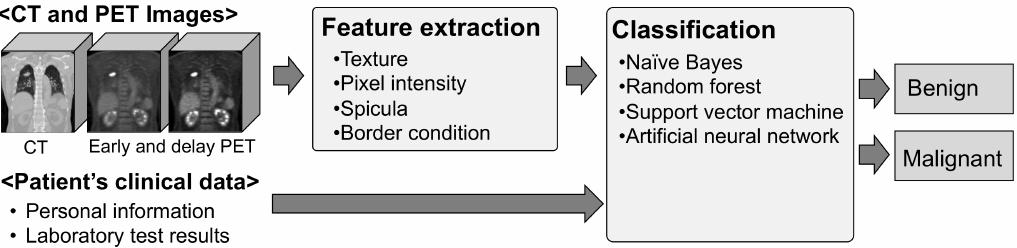
Figure 1. Overview of the proposed